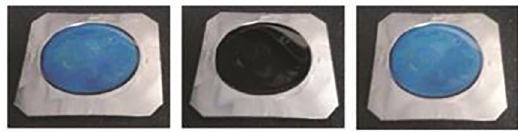
Figure 9. Color variation of LC in the temperature sensor prototype: on the left, heating from 80 to 90 °C; in the center, isotropic phase at temperatures above 100 °C; on the right, cooling from 90 to 80 °C.